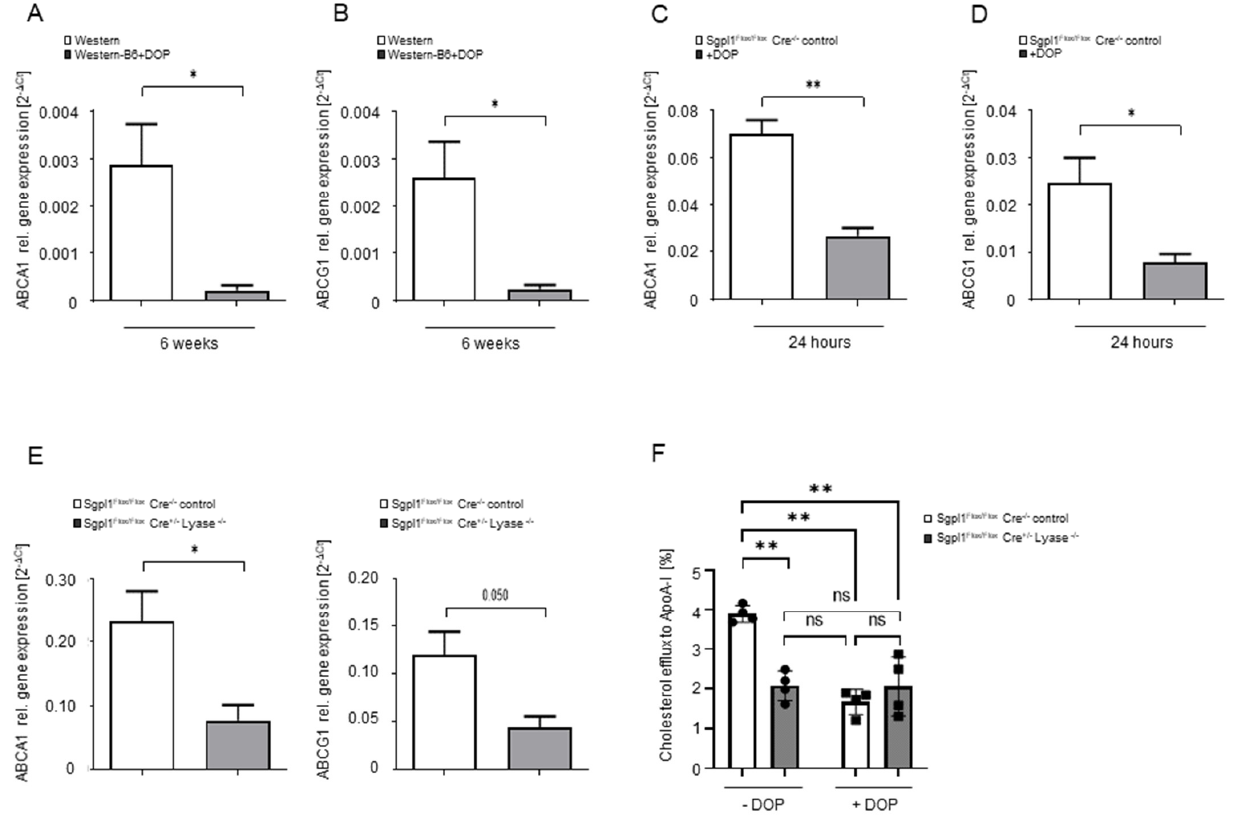
Figure 6. S1P lyase inhibition and deficiency lead to ABCA1 and ABCG1 gene downregulation and reduced cholesterol efflux. ( A , B ) Quantification of ABCA1 and ABCG1 gene expression by qRT-PCR analysis in thioglycollate-elicited peritoneal macrophages from mice treated or not with DOP for 6 weeks. ( C , D ) ABCA1 and ABCG1 gene expression in Sgpl1 Flox/Flox Cre − / − macrophages treated with 0.25 mM DOP or not for 24 h. ( E ) ABCA1 and ABCG1 gene expression in peritoneal macrophages from Sgpl1 Flox/Flox Cre − / − and Sgpl1 Flox/Flox Cre +/ − mice. Statistically significant differences from controls are indicated as * p < 0.05 and ** p < 0.01 (Student’s t -test). ( F ) [ 3 H]-cholesterol efflux to ApoA-I under basal conditions and after treatment with 0.25 mM DOP for 24 h in peritoneal macrophages from Sgpl1 Flox/Flox Cre − / − and Sgpl1 Flox/Flox Cre +/ − mice. Statistical analysis was performed using a two-way ANOVA followed by a Tukey’s post hoc test. Statistically significant differences are indicated as * p < 0.05 and ** p <